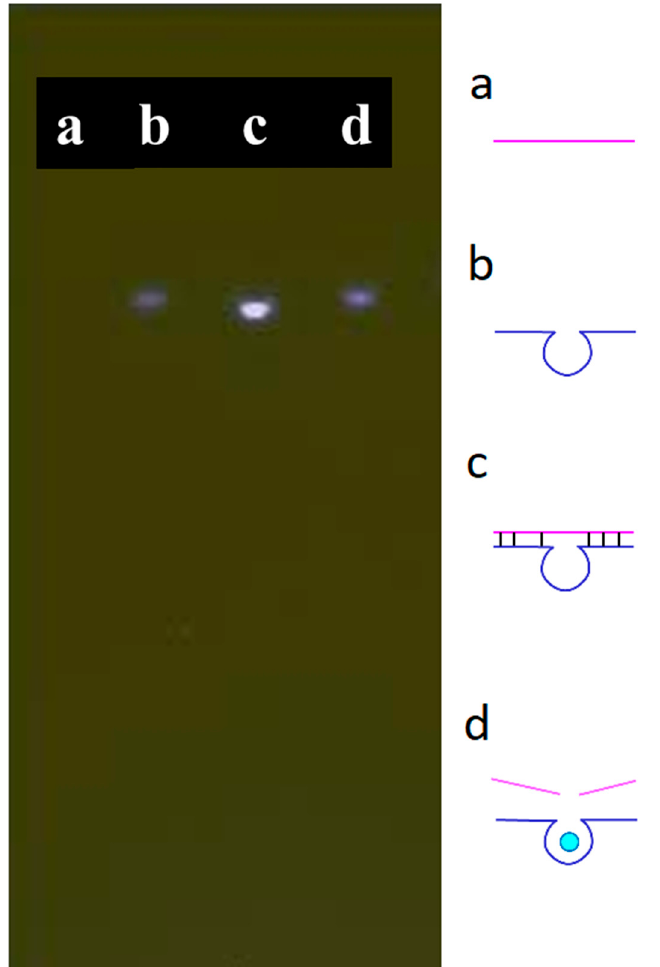
Figure 1. Gel electrophoresis of the designed substrate and DNAzyme: ( a ) substrate, ( b ) DNAzyme, ( c ) substrate + DNAzyme, and ( d ) substrate + DNAzyme + Cu 2+ . Conditions: 500 nM for each compound, 50 nM of Cu 2+ . Separated with 2% agarose gel with added 1x SYBR ® Green I; 300 V for 10 min.